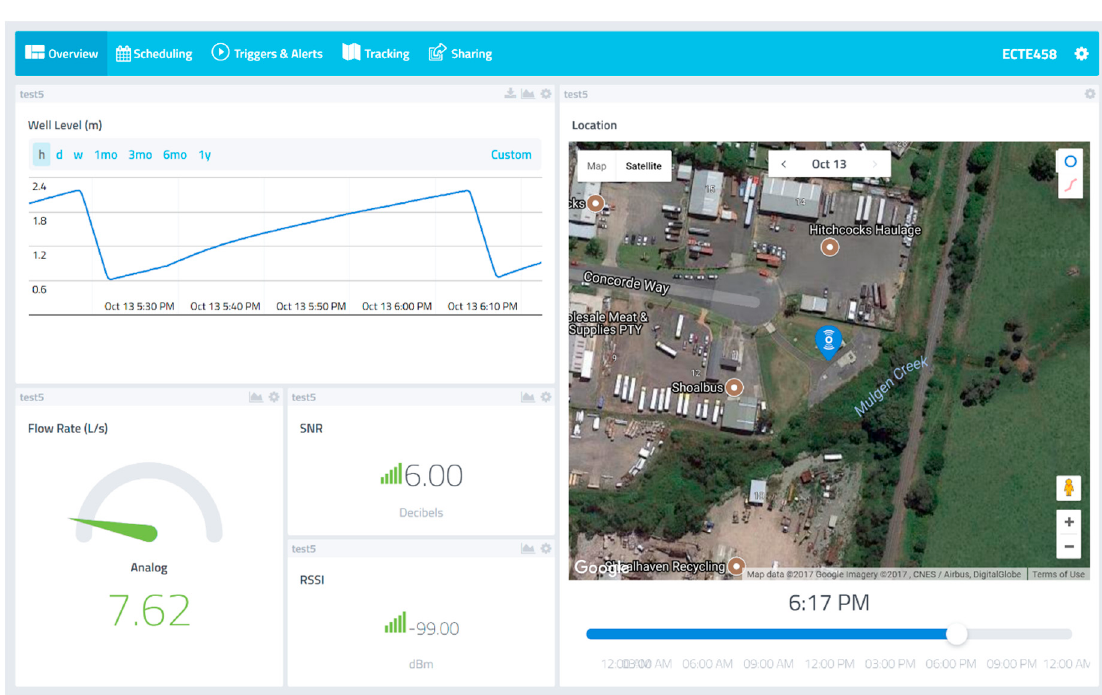
Figure 21. Cayenne IoT Project Builder.